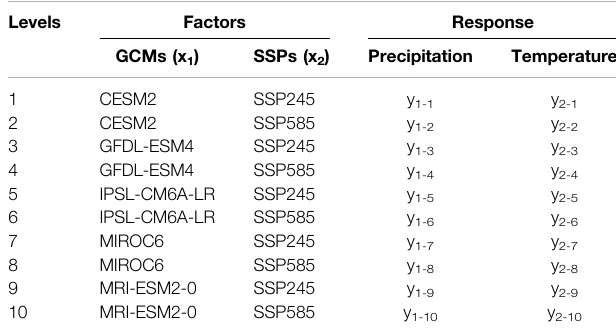
TABLE 2 | The multi-level factorial design for the sources of uncertainty of future precipitation and temperature projection.